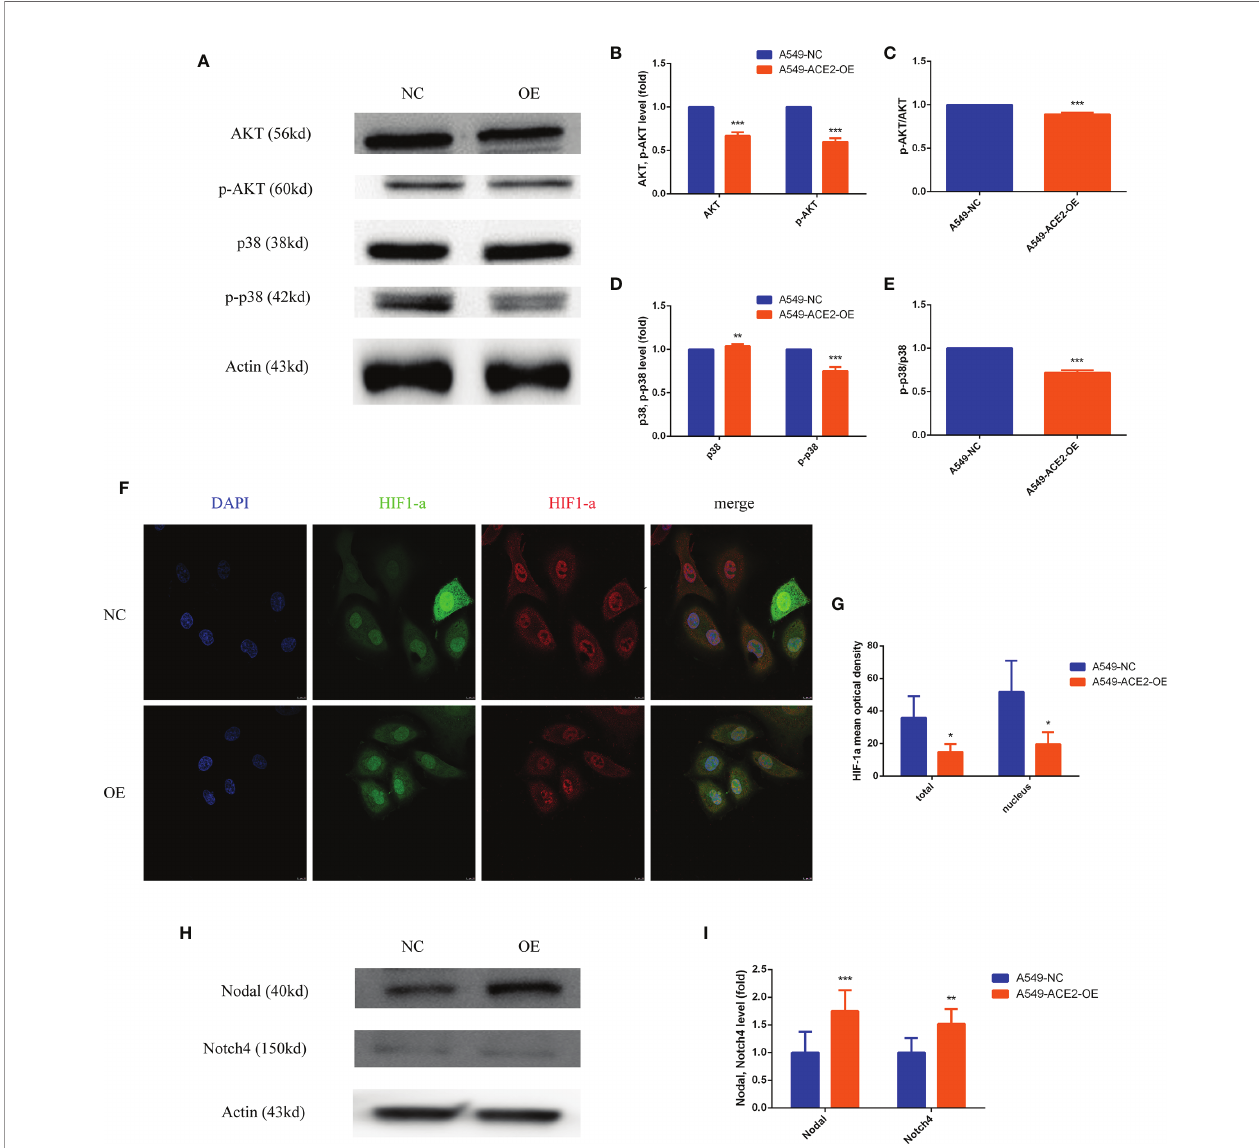
FIGURE 7 | PI3K/AKT, p38MAPK, and HIF1-a were inactivated, and Nodal/Notch4 pathway was activated in A549-ACE2-OE cell model. (A – E) Western blot analysis and quanti fi cation of AKT, p-AKT, p38, and p-p38 expression level in A549-ACE2-OE cells and negative control, Mean ± SD, n = 3, ***p < 0.001, **p < 0.01. (F, G) Immuno fl urescence assay and quanti fi cation of HIF1-a mean optical density in A549-ACE2-OE cells and negative control, Mean ± SD, n = 4, *p < 0.05. (H, I) Western blot analysis and quanti fi cation of Nodal and Notch4 expression level in A549-ACE2-OE cells and negative control, Mean ± SD, n = 3, ***p < 0.001, **p <